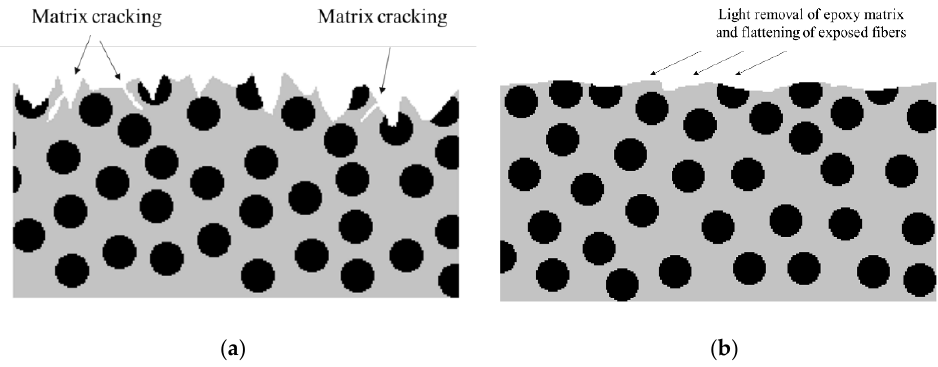
Figure 4. Schematic design of composite after ( a ) grit blasting and ( b ) sanding. Adapted from [72].